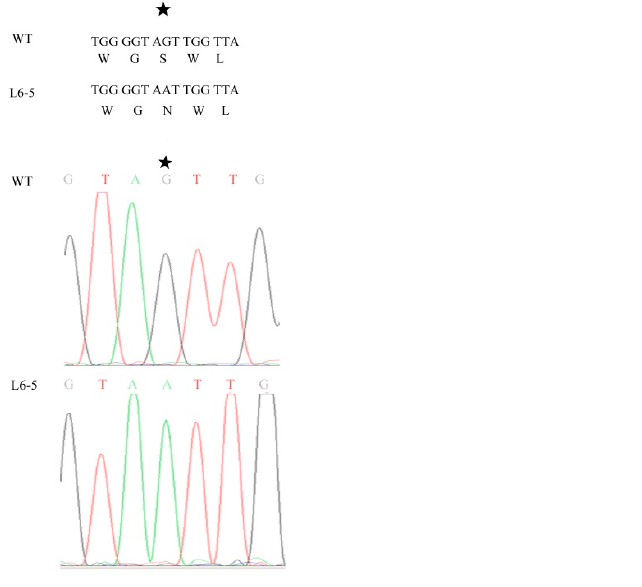
Figure 6. The gene expression analysis of nonsense mutations genes which involved in the flavone and flavonol biosynthesis pathway. in the L6-5. The L6-5 was the white fruit mutants and the nonsense mutations genes were mapped to the flavone and flavonol biosynthesis.